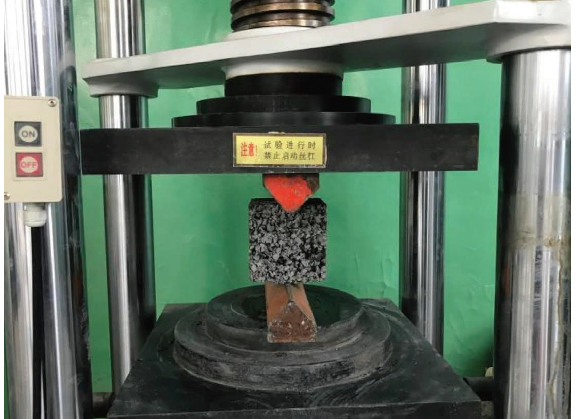
Figure 8: Split tensile test